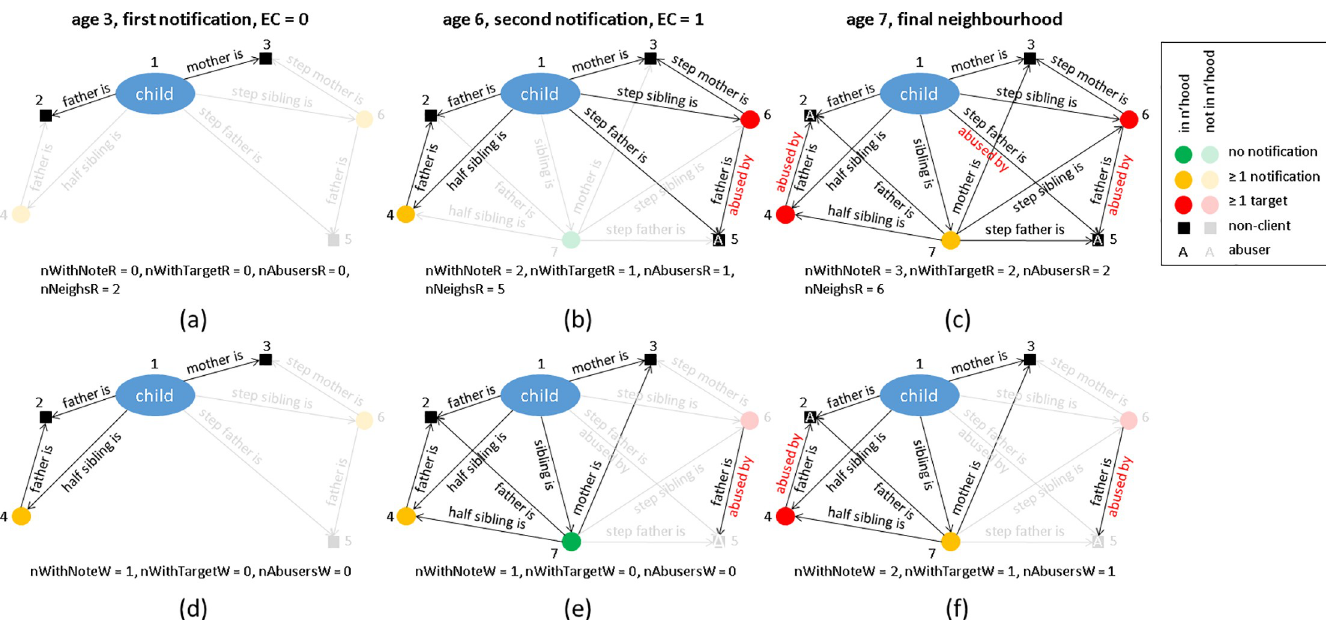
Fig 1. A child’s family network growing over time. Panels (a)-(c) show networks constructed using recorded relationships and panels (d)-(f) show networks constructed using whole-life-relationships. The networks are shown at: (a,d) the time of the child’s first notification; (b,e) the time of the child’s second notification; (c,f) the end of the data collection period. Individuals who are part of the child’s family network at each time point are shown in dark colours; individuals who exist but are not part of the network are shown in light colours; individuals who are not yet born are not shown. The values of the network predictor variables (see Table 1 for definitions) are provided in each case. This is an illustration only and does not correspond to a real